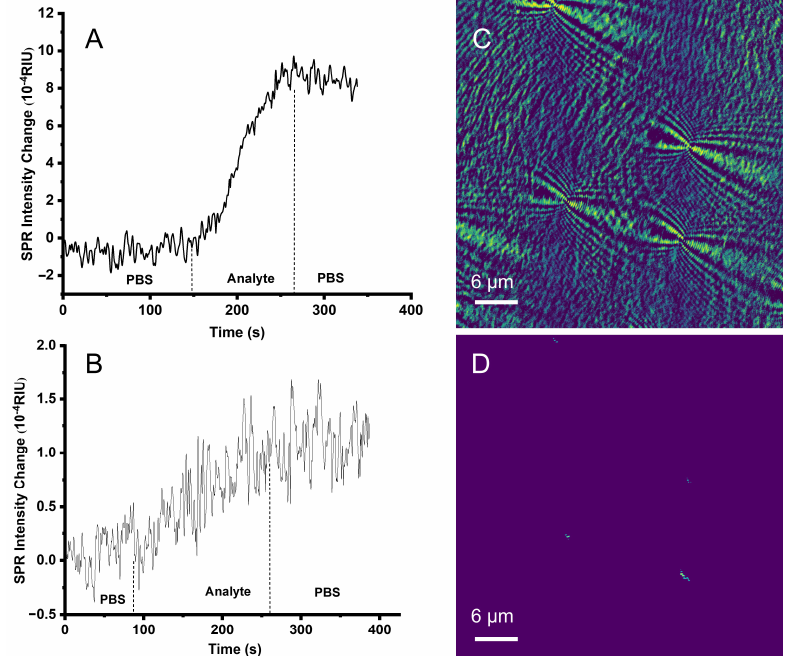
Figure 7. Transferrin-specific binding experiment. ( A ) Binding curve of mixture-PS and transferrin antibody 1; ( B ) binding curve of mixture-noPS and transferrin antibody 1 in the control group; ( C ) SPRM image during the binding process; and ( D ) reconstruction image of ( C